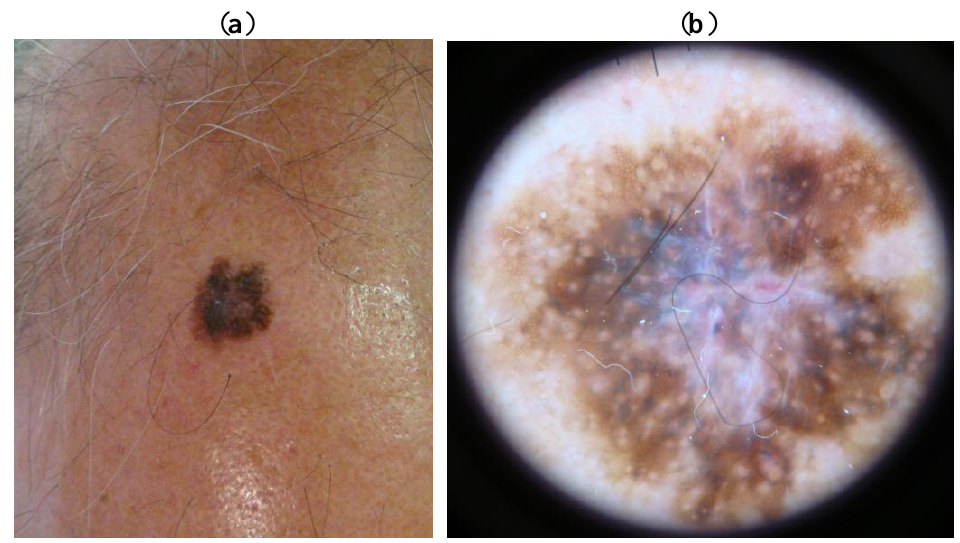
Figure 1. Case 1. ( a ). Naked eye aspect: a 14 mm asymmetric brownish to black patch, with irregular borders; ( b ). Dermatoscopic aspect: a multicomponent pattern, with a dark brown rhomboidal structures around the hair follicles, with peripheral asymmetric, atypical pigment network, and a central blue-grey veil.